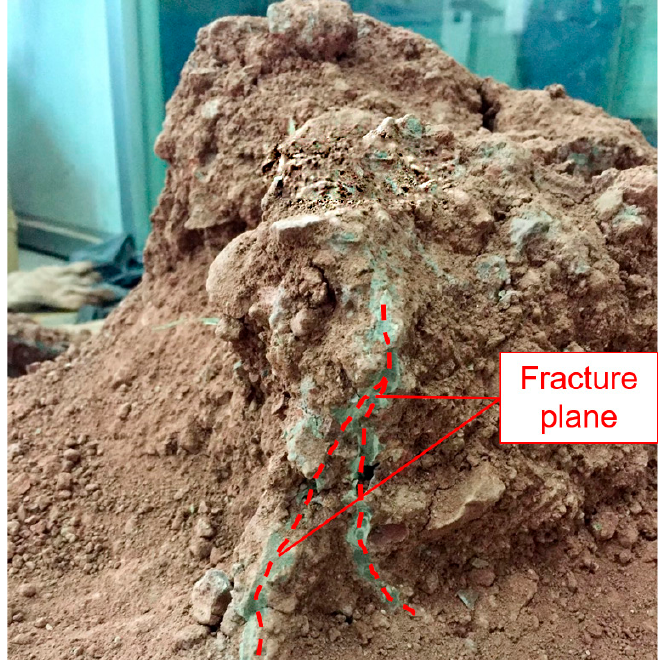
Figure 15. Detailed drawing of the concretion of Group #7.